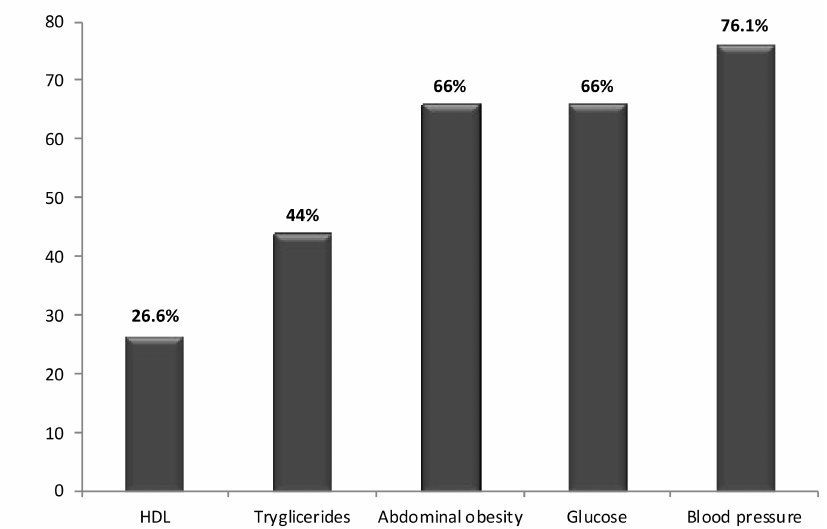
Figure 7. Prevalence of associated factors in the population with early kidney